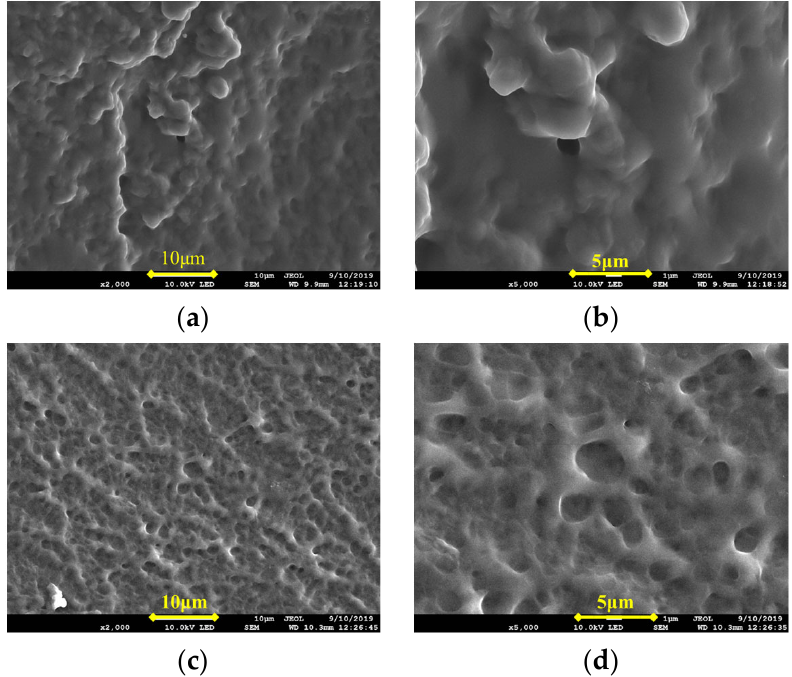
Figure 1. SEM images of frozen colloids prepared at reaction temperatures of 60 ◦ C and 80 ◦ C. ( a ) 60 ◦ C × 2000; ( b ) 60 ◦ C × 5000; ( c ) 80 ◦ C × 2000; and ( d ) 80 ◦ C × 5000.